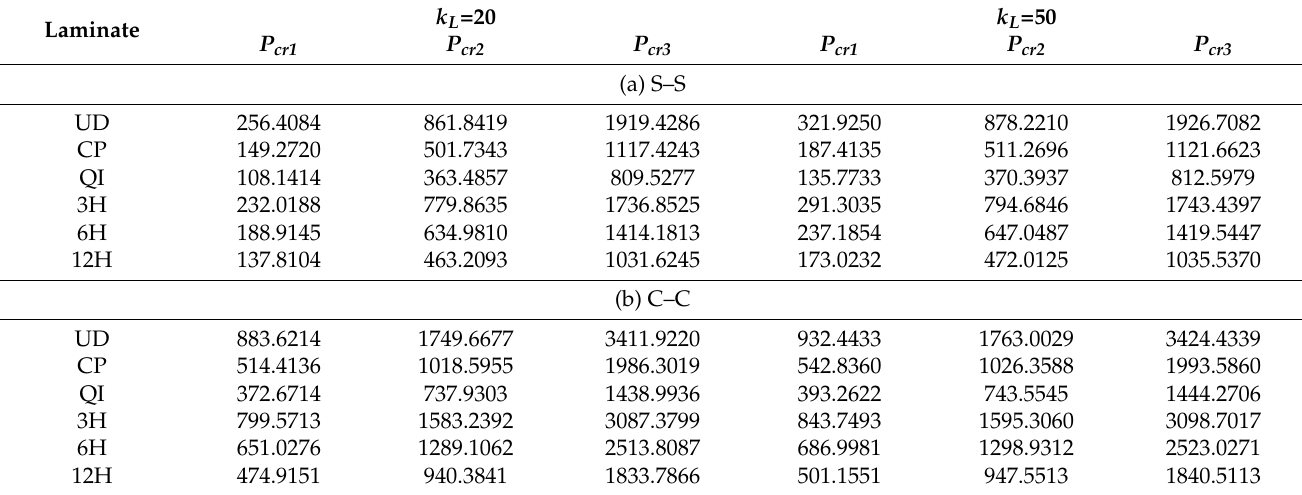
Table 2. First three critical buckling loads ( N ) of perfect S–S and C–C composite beams for different layups ( k s = 0, L = 100 h ).